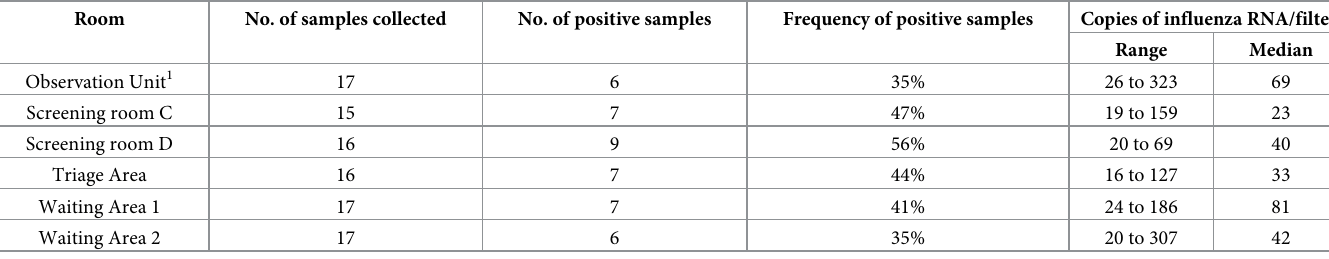
of detection, and between 20 and 307 copies of virus detected per filter. During eight of the 125 shifts sampled, a participant was in contact with a confirmed influ- enza patient. Of these eight participants (Table 5), four had positive personal bioaerosol sam- plers with a copy number ranging from 29 to 321. One participant, a RN, had contact with five patients with confirmed influenza. The personal bioaerosol sampler for this participant was positive for influenza with 128 copies (89 copies/m 3 ), while a participant with one contact had Table 4. Frequency of identifying influenza in room aerosol samples in an adult emergency department.